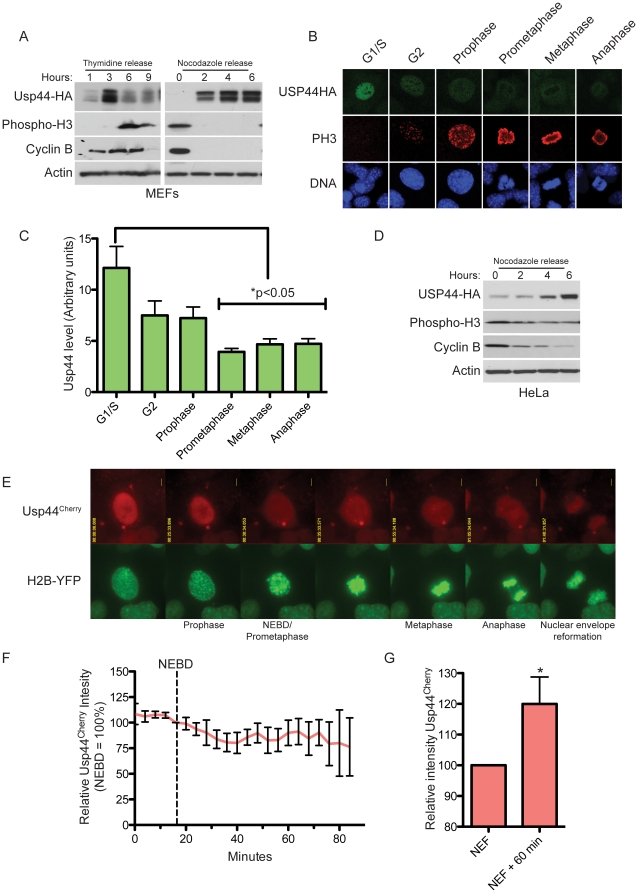
Usp44 undergoes degradation prior to mitosis.(a) Immunoblot of cells expressing Usp44-HA previously synchronized with double thymidine (DT) or nocodazole (Noc). Samples were harvested at the indicated times after release, and were immunoblotted with the indicated antibodies. (b) Immunofluorescence images of Usp44-HA in different cell cycle phases. G1/S, G2, and prophase cells were distinguished based on the patterns of chromosome condensation and phospho histone H3 staining (absent in G1/S, punctate in G2 and prophase). Staining performed with the indicated antibodies. (c) quantitation of immunofluorescence from (b). Levels of HA immunoreactivity were determined using imageJ (n = 8 cells each). (d). HeLa cells were analyzed as in (a). (e) Time-lapse images of a representative mitotic MEF expressing Usp44Cherry and H2B-YFP. Relative times are indicated. (f) Quantitation of Usp44Cherry fluorescence (n = 10) in MEFs monitored by live-cell microscopy from late G2 through anaphase. The levels of mCherry fluorescence were determined using imageJ. (g). MEFs expressing Usp44Cherry (n = 9) were monitored by live cell microscopy and the levels of mCherry fluorescence was measured at nuclear envelope re-formation (NEF) and at NEF+60 minutes. * p<0.05 calculated with an unpaired t-test. Error bars represent the SEM.